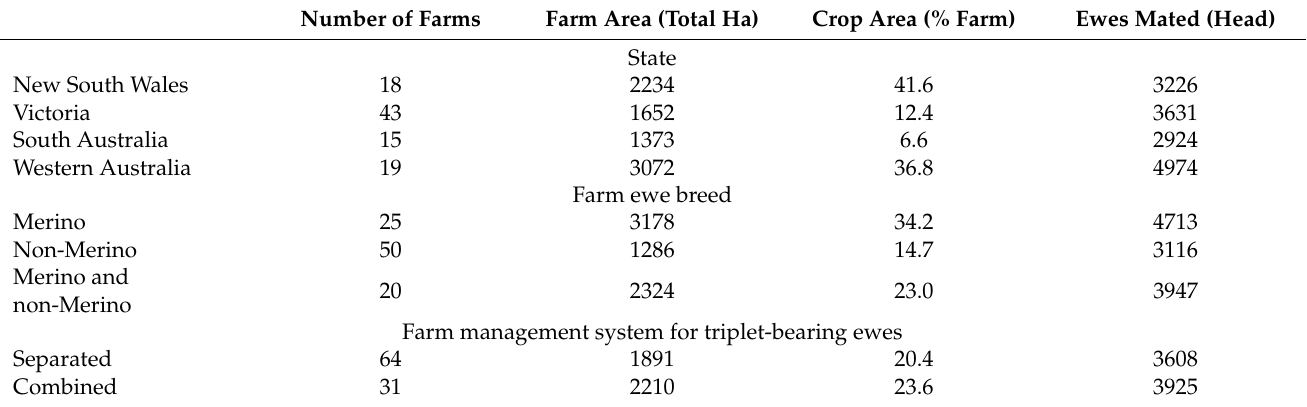
Table 1. Number of farms, average size of farms, proportion of the farms cropped and total number of ewes mated for survey participants across Australia in 2017 and 2018. The farm-level benchmarking data are presented for different states, ewe breed types on each farm (Merino, non-Merino or both) and the management system utilised for triplet-bearing ewes (‘Separated’ or ‘Combined’ with twin- bearing ewes). The ewe management system for a farm was classified as ‘Separated’ if the triple- bearing ewes for at least one ewe flock were identified and separated from twin-bearing ewes in either 2017 or 2018. Number of Farms Farm Area (Total Ha) Crop Area (% Farm) Ewes Mated (Head)